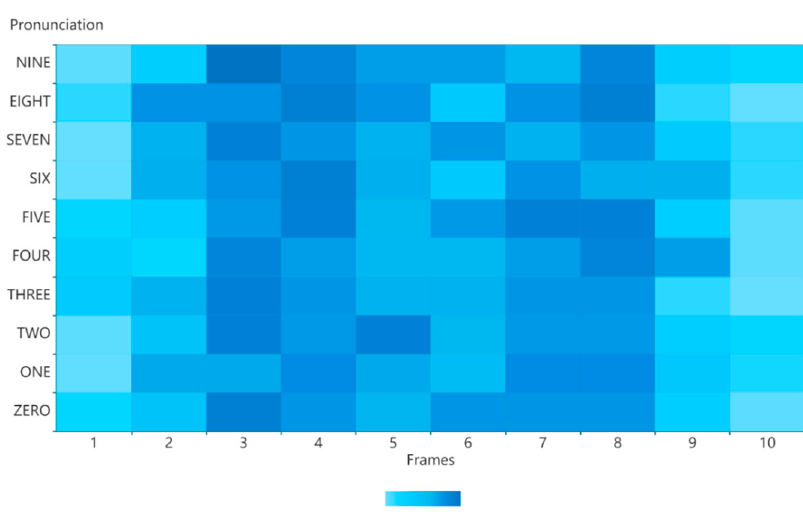
Figure 9. Visualization of the attention mechanism.